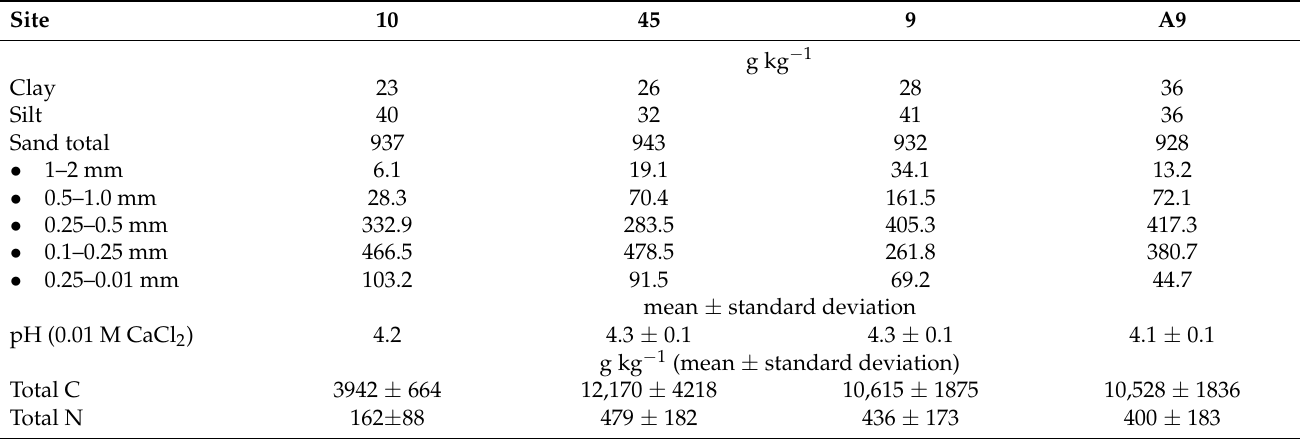
Table 1. Soil particle size distribution and mean and standard deviation (SD) of soil data at each experimental site across 144 plots in June 2014.